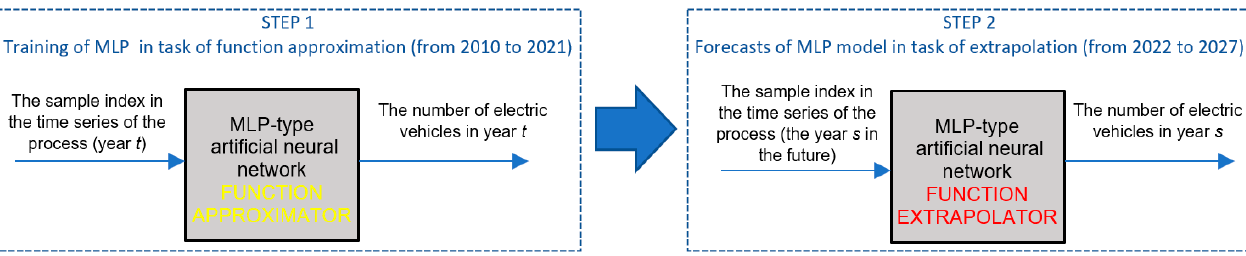
Figure 5. Application of MLP to forecasts of EV numbers.